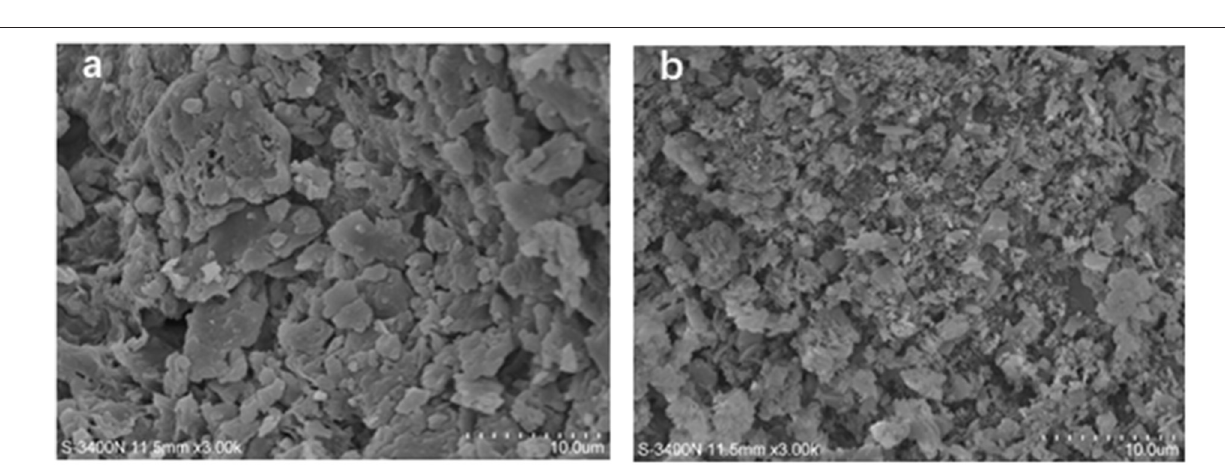
FIGURE 8 | Scanning electron microcopy (SEM) images of the SDF from orange peel [ (a) control, (b) treated by PEF at electric field intensities 6.0 kV/cm and the number of pulses 30). PEF treatment parameters: electric field intensities 6.0 kV/cm, the number of pulses 30, the extraction time of 20min, liquid-solid ratios of 15:1 and temperature of 45 ◦